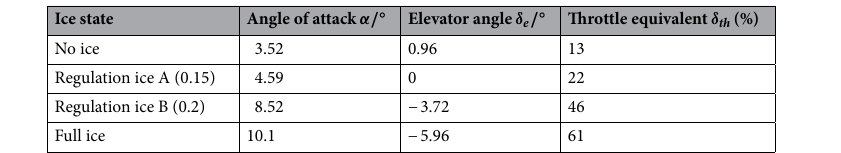
Table 4. The initial values for dynamic